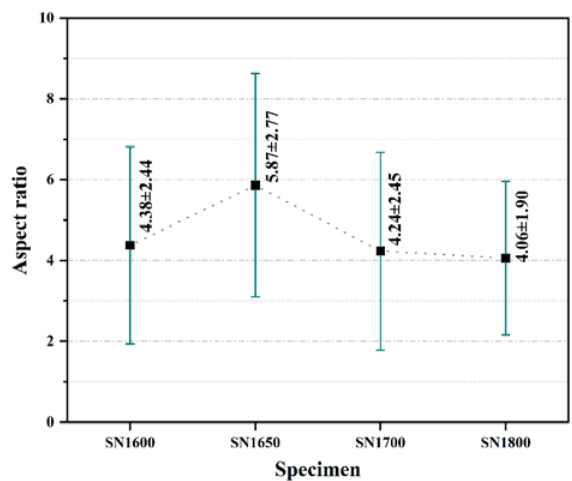
Fig. 6 Aspect ratios of the elongated grains in monolithic Si 3 N 4 ceramics sintered at different temperatures.